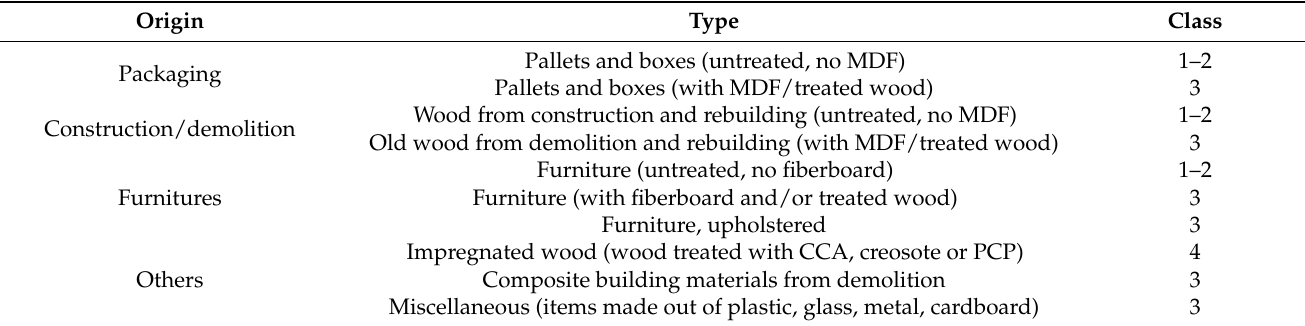
Table 1. Classification of wood waste according to its origin (adapted from [15]).